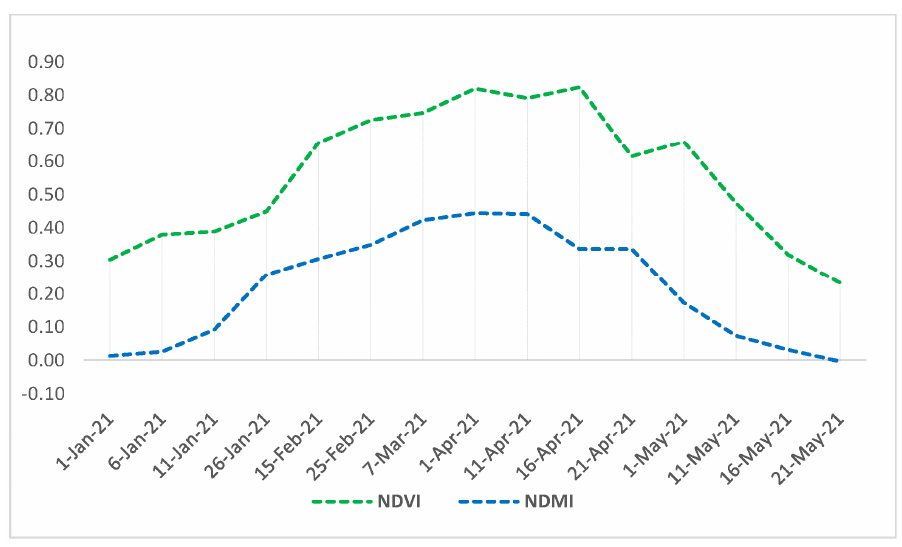
Figure 12. Temporal variation of the NDVI and NDMI value-based vegetation density classes of Center pivot wheat field from 1 January to 21 May 2021.